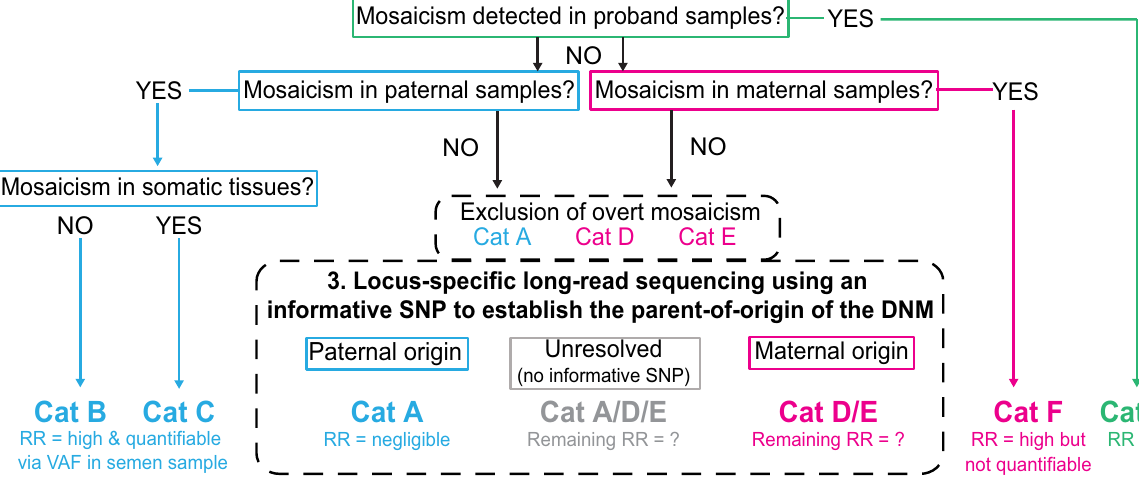
or instances of post-zygotic mosaicism in the proband. For those families without evidence of overt mosaicism, haplotyping using long-read sequencing (MinION platform from Oxford Nanopore Technologies (ONT)) was performed to resolve theparentaloriginoftheDNMandfurtherstratifytherecurrencerisk(RR).Referto Fig. 1 for category (Cat)